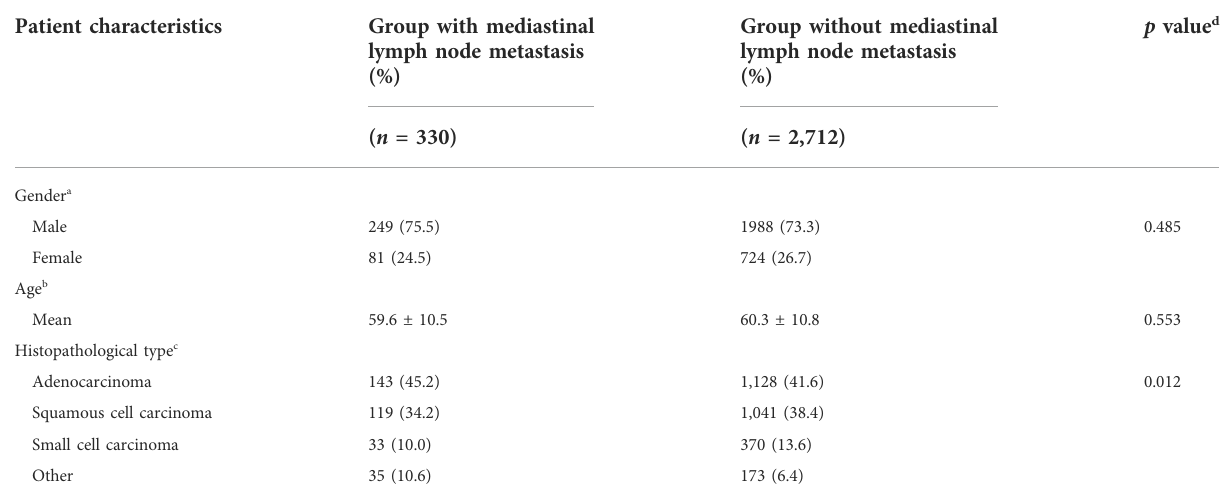
TABLE 1 The clinical characteristics of patients with lung cancer. Patient